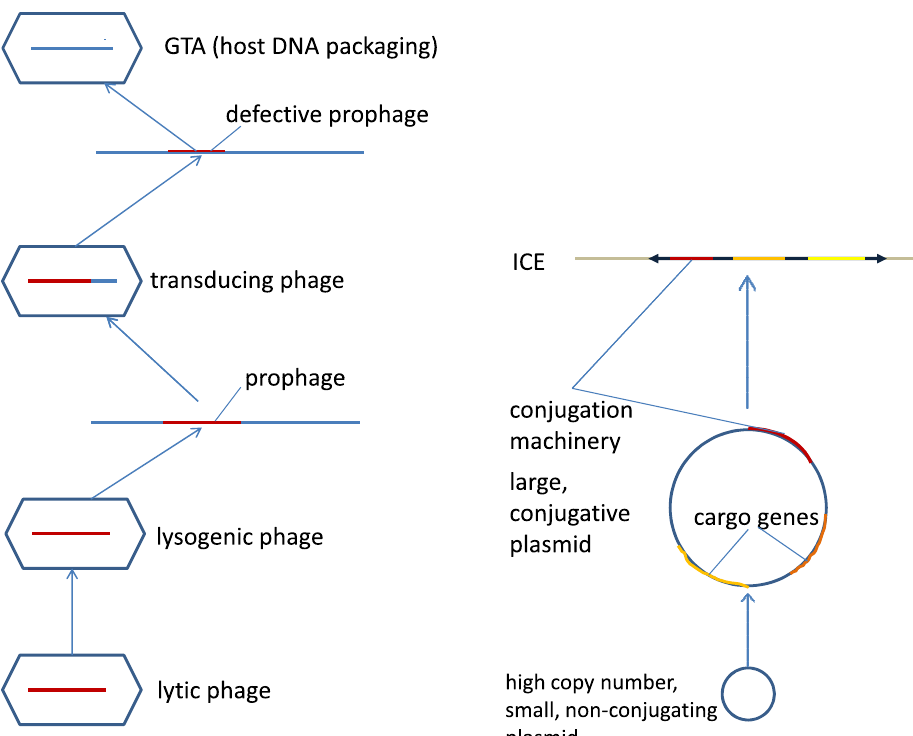
Figure 1. Domestication of selfish genetic elements en route to dedicated vehicles for horizontal gene transfer. The figure depicts the hypothetical stages of the evolutionary paths from a lytic phage to a gene transfer agent and from a small, high copy number plasmid to an integrative and conjugative element. Abbreviations: GTA, gene transfer agent; ICE, integrative and conjugative